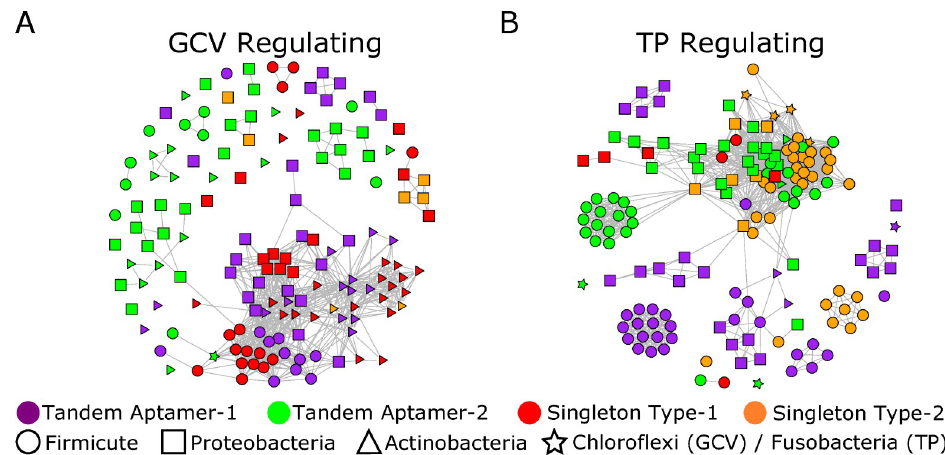
Fig 5. Clustering of random glycine riboswitch aptamers across the bacterial kingdom. A) Network visualization of 150 randomly chosen aptamers regulating GCV and clustered based on RNAmountAlign pairwise similarity (threshold -5). B) Network visualization of 150 randomly chosen aptamers regulating TP and clustered based on RNAmountAlign pairwise similarity (threshold -5). Only singletons that could be classified as type-1 or type-2 were included in this